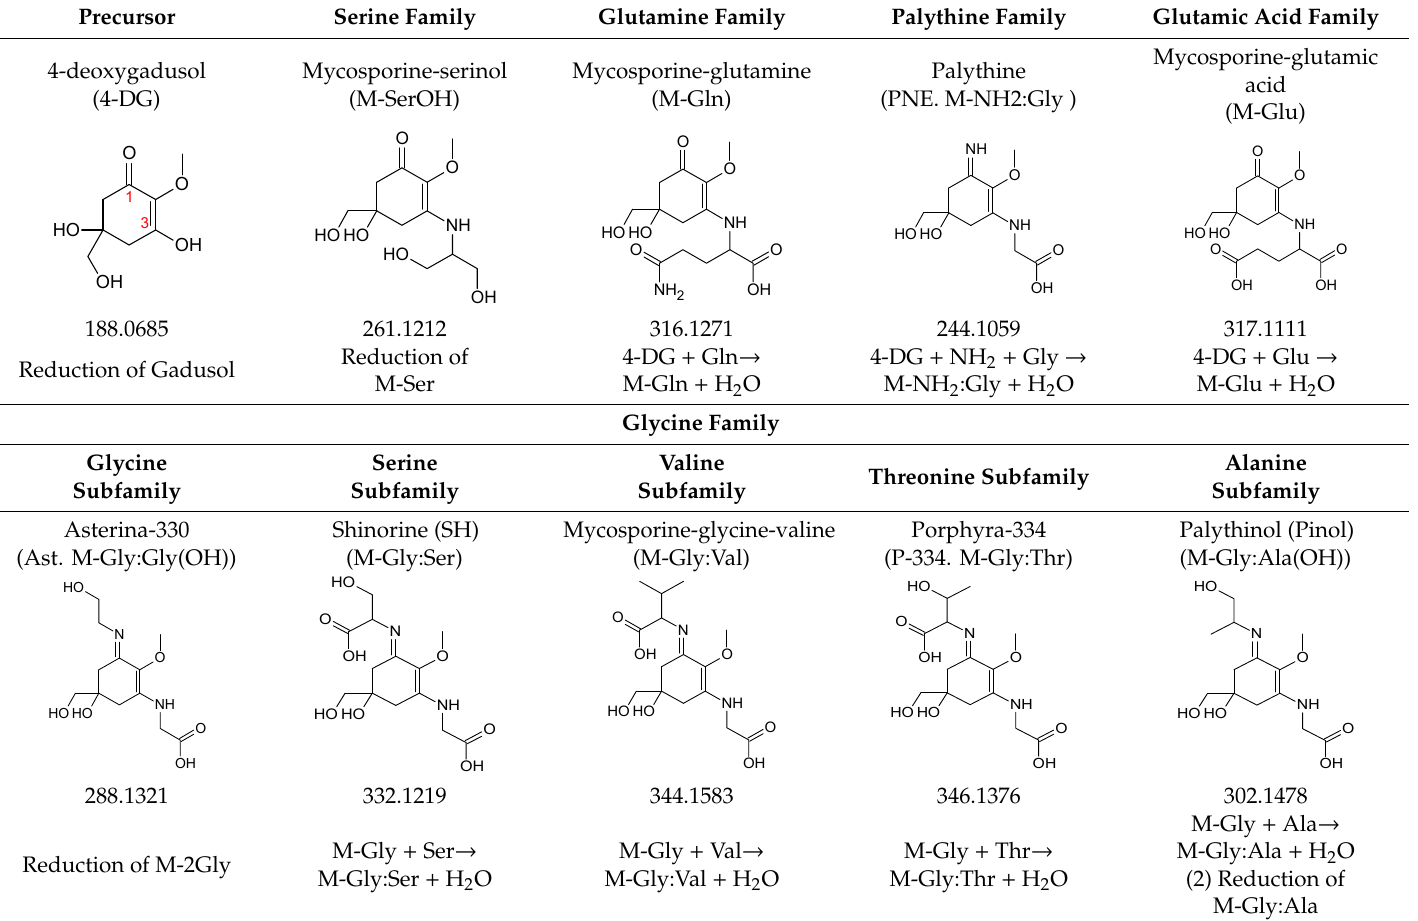
Table 1. Classification of mycosporines, MAAs and their precursor reported in the literature. The structure and the theoretical monoisotopic mass (Da) were detailed for every compound classified in five families depending on their amino acid substituents on the C3. The structural relationships were briefly described for every example [9].